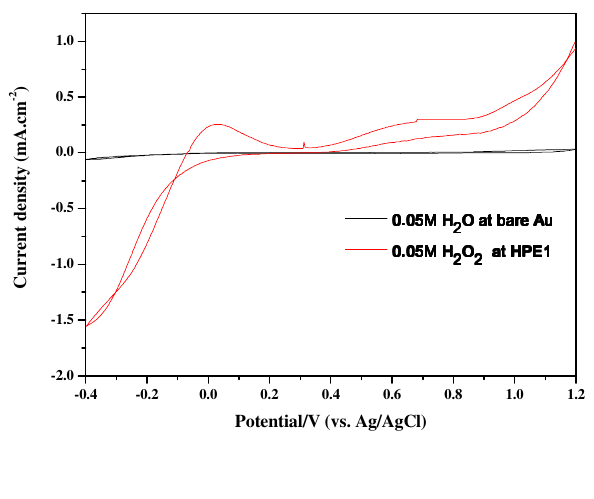
Figure 4. Cyclic voltammograms of 0.05 M H